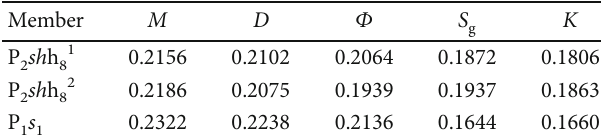
Table 2: Weighted coe ffi cients of the members in the Su-54 block of the western Sulige gas fi eld.